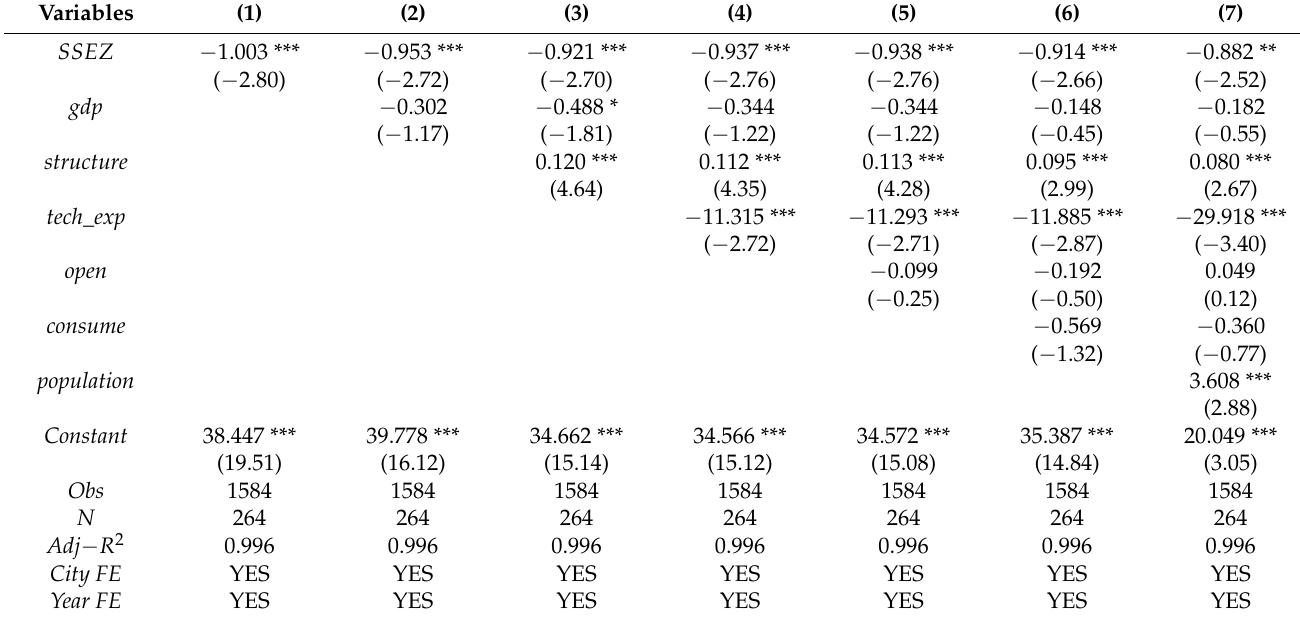
Table 2. Baseline regression results (Model